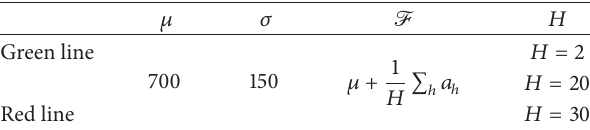
Table 2: Shocks 𝑎 ℎ below are independent and uniformly dis- tributed in [−𝜃,𝜃] where 𝜃 is adjusted as 𝐻 changes so as to keep 𝜎